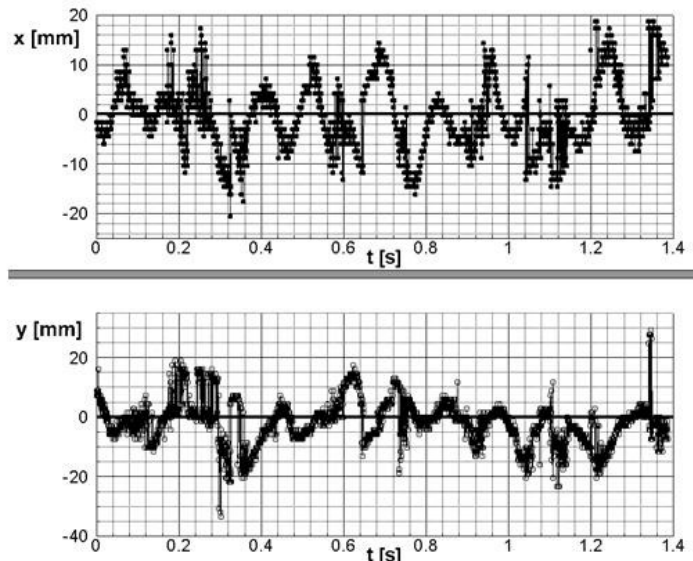
Figure 4. Time record of the total velocity minima in the measuring section ( x c (filled circles) and y c (empty circles) are coordinates of the vortex center).